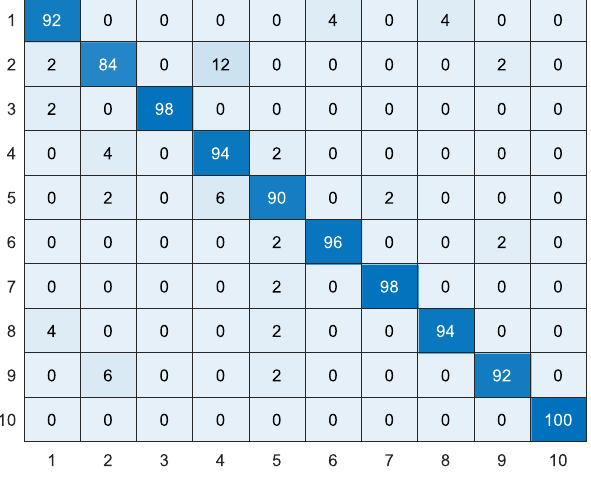
Figure 12. The confusion matrix obtained by WTLD_kirsch with SVM of linear kernel function (%).